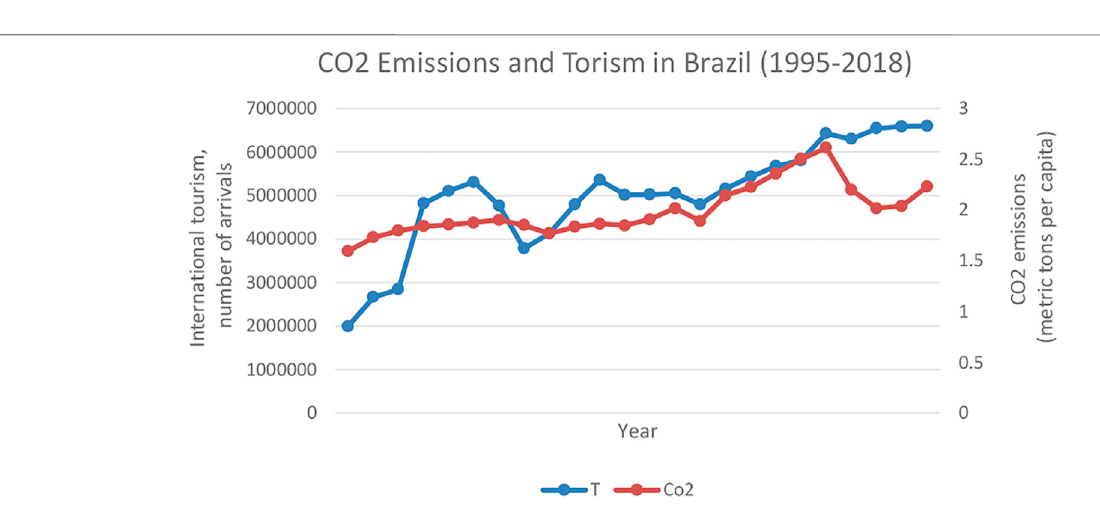
FIGURE 3 | CO 2 emissions and tourism in Brazil (1995 – 1918). Source: World Development indicators (2020).